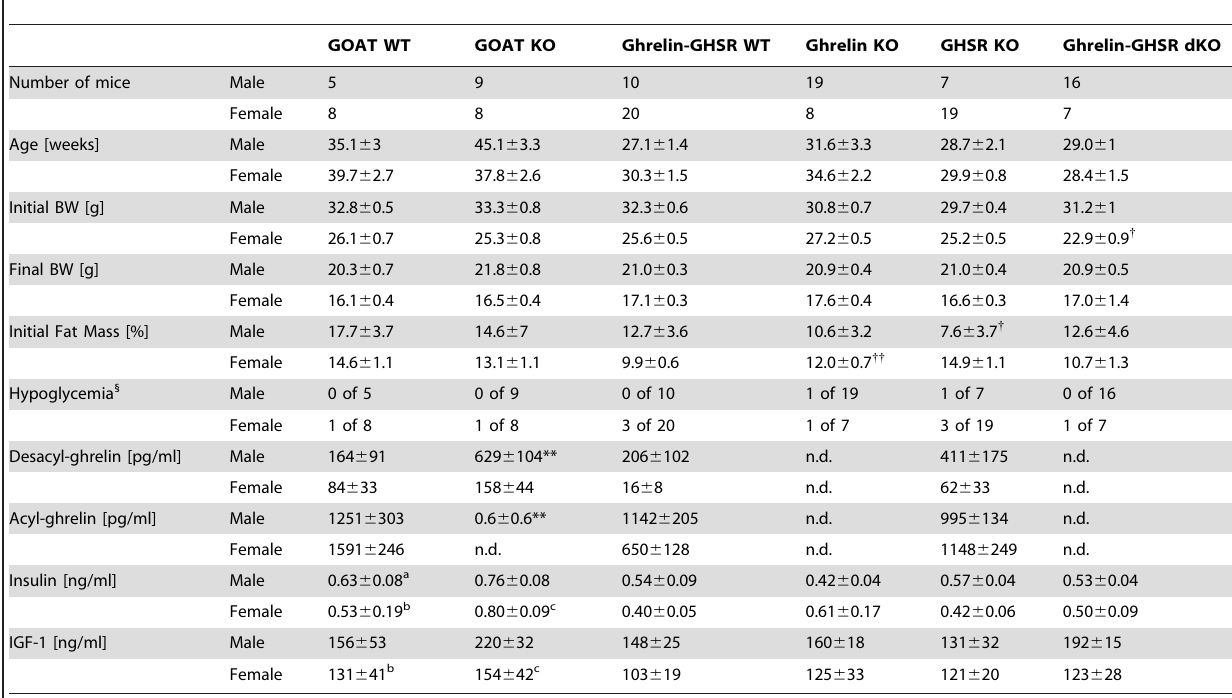
Table 1. Number, age, initial vs. final body morphometry, and final acyl/desacyl-ghrelin, insulin and IGF-1 plasma levels of loss-of function ghrelin or their respective WT control mice after